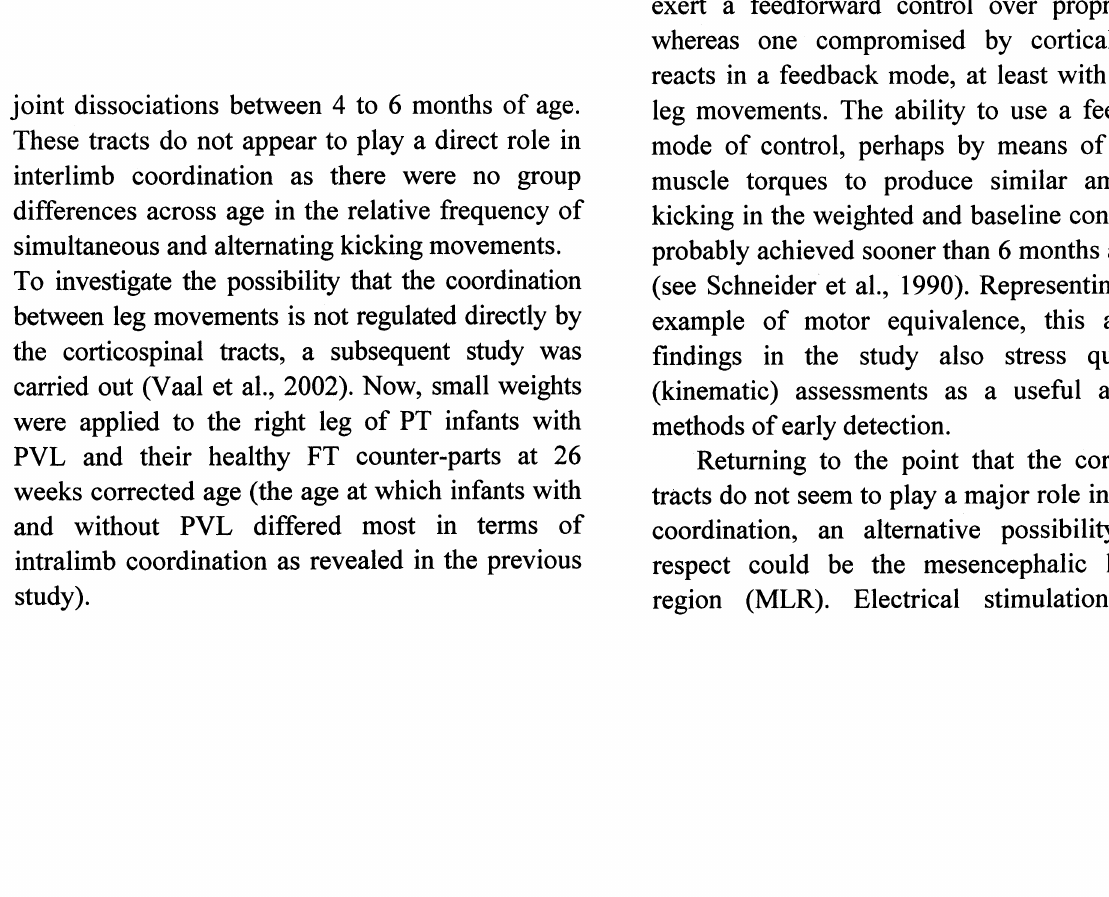
Fig. 5: Mean hip-knee correlations, converted to Z-scores, obtained longitudinally for healthy fullterm infants (o) and those with periventricular leukomalacia (o) during spontaneous kicking at the (corrected) ages of 6, 12, 18 and 26 weeks. Excluded from this figure are those infants with mildly and moderately abnormal indications of periventricular leuko- malacia. Similar age-related trends were found for the hip-ankle and knee-ankle cross-correlations (see Vaal et al.,